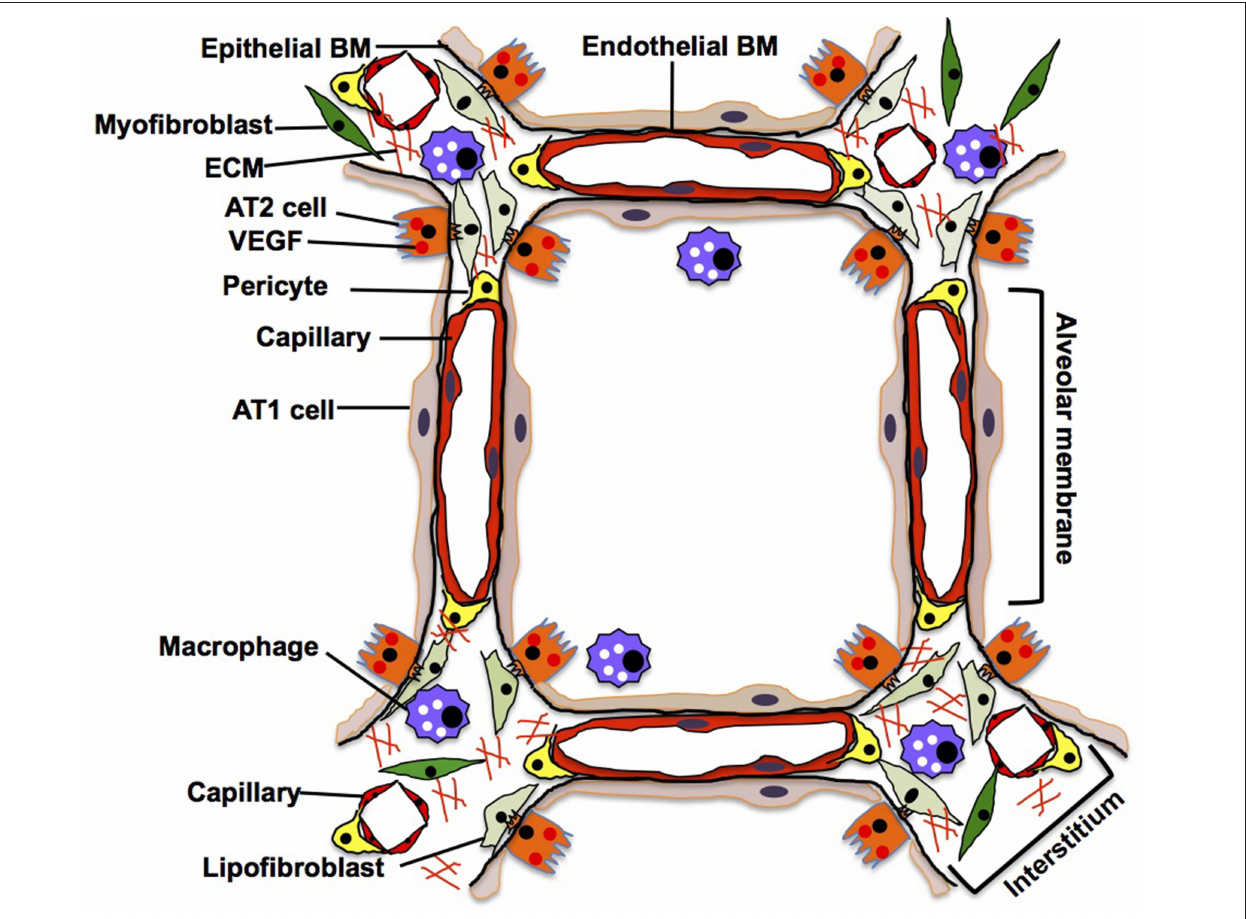
FIGURE 4 | Adult lung. In adult alveoli, alveolar membrane (thin part of the alveolar wall) is simply composed of sheet-like AT1 cells, intermediate basement membrane (BM) and capillary ECs, while alveolar interstitium, a thick portion of the alveoli, consists of stromal cells (e.g., fibroblasts, pericytes, macrophages), fibrillar ECMs and separated capillaries. AT1 cells tightly share the basement membrane with capillary ECs in the alveolar membrane. In the interstitium, fibroblasts play a critical role in supporting the capillary structures by remodeling the local ECM components and supplying growth